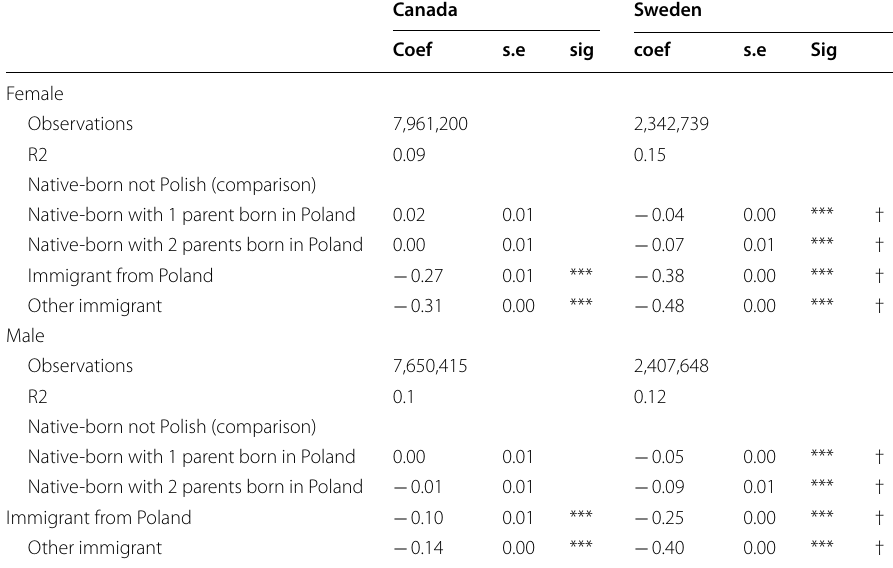
Table 4 Marginal effect (at the average of all coefficients) of being employed, Canada and Sweden, 2015 /